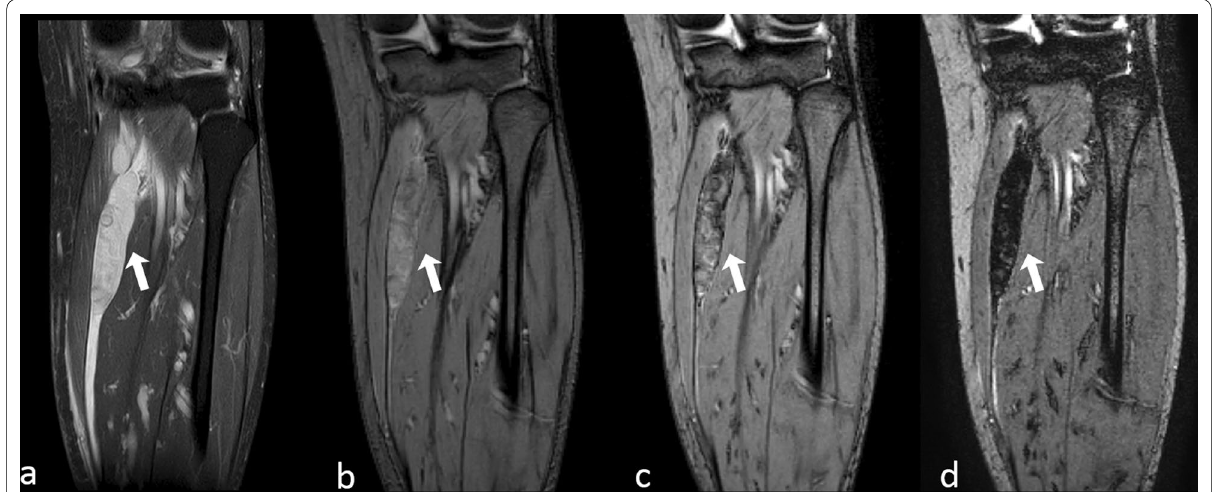
Fig. 10 A 58-year-old woman with symptoms of chronic compartment syndrome of the right lower leg. Coronal turbo spin echo (TSE) T2-w. fat-saturated image a shows an ovoidal mass (arrow) between the muscles of the posterior compartment. Contrast-enhanced study (not shown) was inconclusive. On gradient echo (GE) T2*-w. images obtained simultaneously with different echoes—8, 16 and 40 ms ( b–d ), respectively— evident and homogeneous blooming of the entire lesion allows to characterize the mass as a hematoma